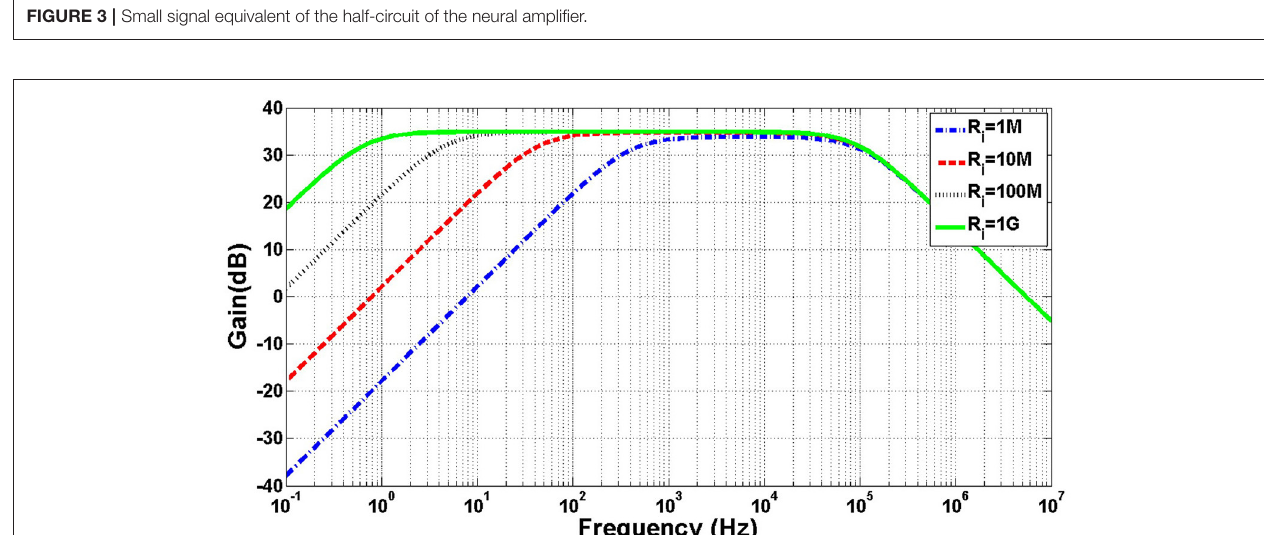
FIGURE 4 | Simulation of frequency response of a neural amplifier with various amounts of R i .